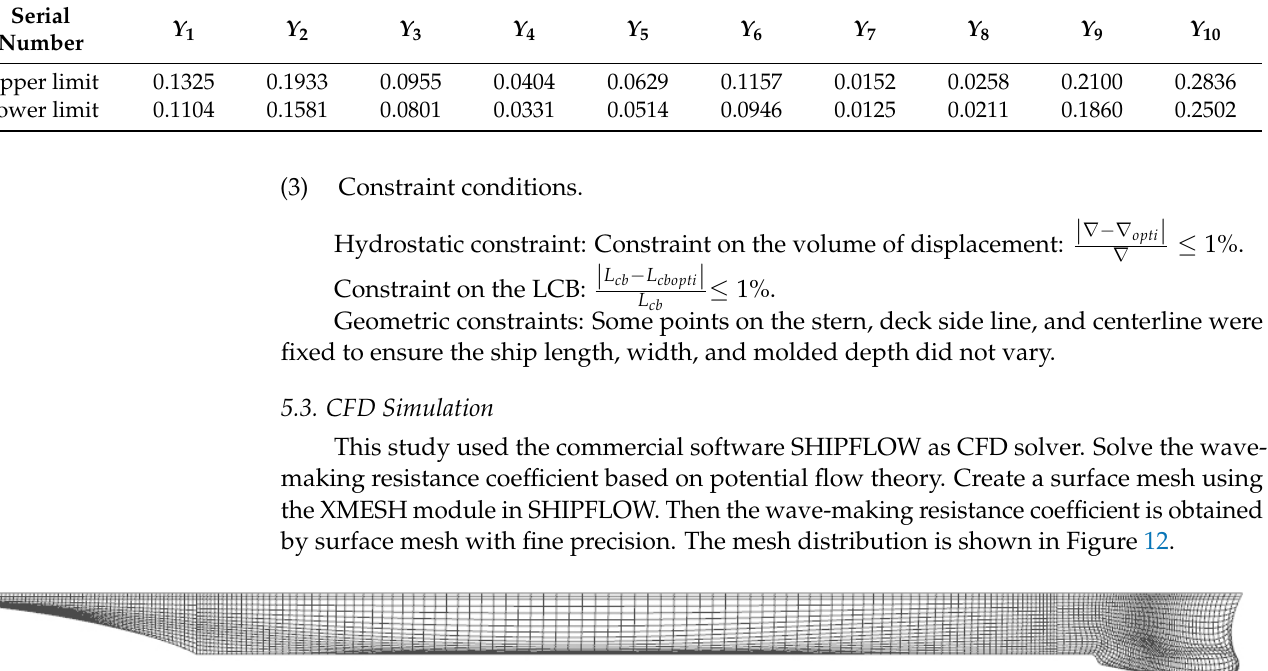
Figure 12. SHIPFLOW meshes of DTMB 5415.